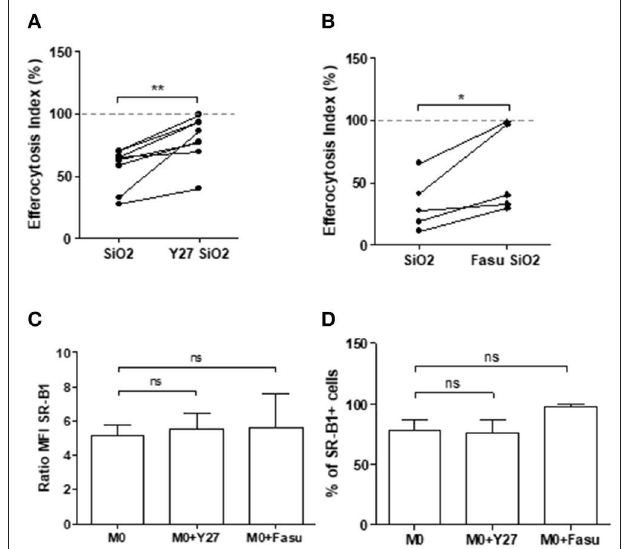
FIGURE 7 | RhoA/ROCK pathway inhibition enhances efferocytosis capacities of silica-exposed MDM and this effect is not due to a down expression of SR-B1 after RhoA/ROCK inhibition. (A,B) EI of MDM pre-treated or not with the ROCK inhibitors (A) Y27632 or (B) fasudil at 20 µ M and treated with 25 µ g/cm 2 of SiO 2 for 4h and then exposed to apoptotic Jurkat cells for 90min (Experiment on MDM from at least 5 different healthy donors). (C,D) Expression of SR-B1 expressed as (C) ratio of MFI and (D) percentage of positive cells of MDM treated or not with the ROCK inhibitor Y27632 and Fasudil at 20 µ M for 4h analyzed by flow cytometry (Experiment on MDM from 2 to 5 different healthy donors). * p < 0.05; ** p < 0.01; ns, not significant.